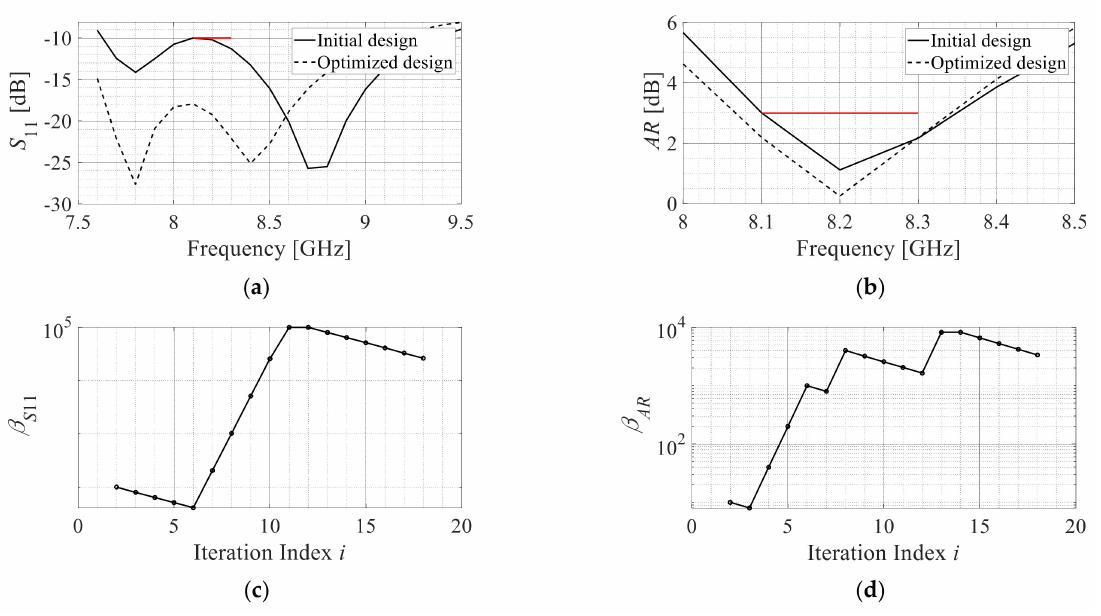
Figure 7. Size reduction in the antenna of Figure 6 using algorithm [41]: ( a , b ) reflection S11 and axial ratio AR, respectively, at the initial (- - -) and optimized design (—), horizontal lines mark design specifications; ( c , d ) evolution of the penalty factors corresponding to S11 and AR, respectively, throughout optimization